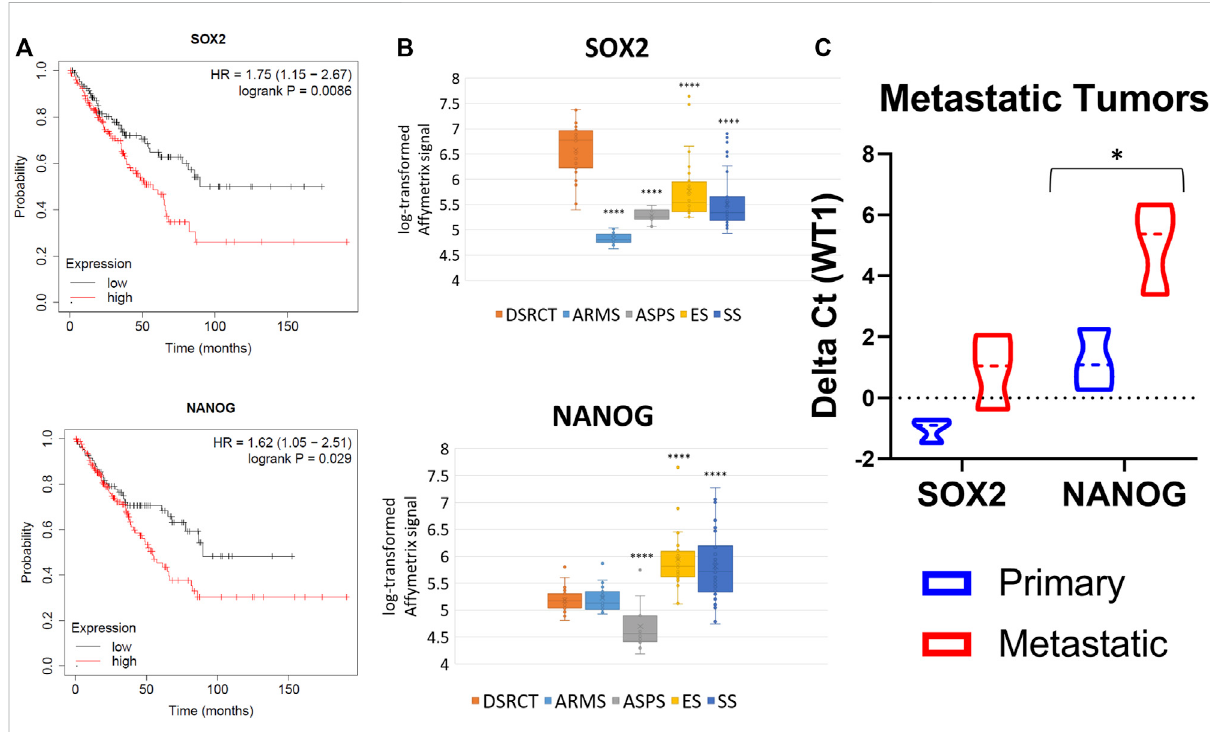
FIGURE 1 Stemness gene expression in DSRCT. (A) Kaplan-Meier curve of sarcoma patient survival based on SOX2 (High n = 152, Low n = 107) and NANOG (High n = 103, Low n = 156)gene expression from KMplotter (total n =259). (B) Relative transcript levels of SOX2 and NANOG inDSRCT ( n = 28) ARMS ( n = 23), ASPS ( n = 12), ES ( n = 28), and SS ( n = 46) primary tumors based on Affymetrix U133A expression array data. (C) Relative SOX2 and NANOG mRNA expression in primary versus metastatic tumors assessed via RT-qPCR ( n = 3, * p < 0.05, Student ’ s t